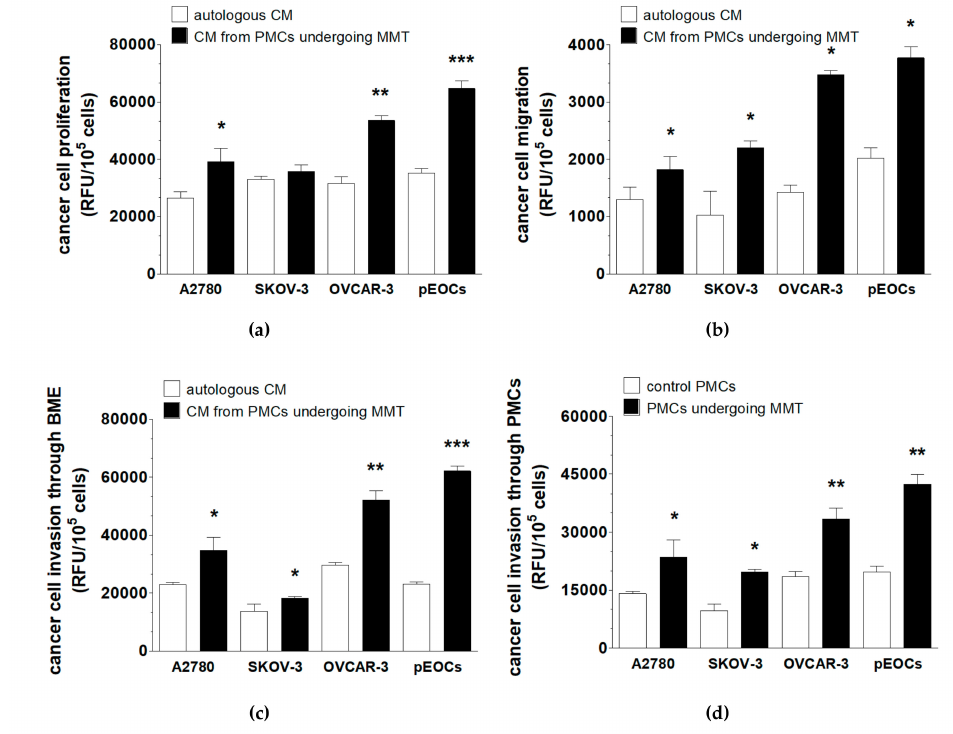
Figure 6. Analysis of the cancer-promoting e ff ects of the PMCs undergoing MMT. E ff ect of the CM generated by cancer cells and PMCs in the MMT state on the proliferation ( a ), migration ( b ), invasion through BME ( c ), and invasion through PMCs ( d ) of the ovarian cancer cells. Experiments were performed with eight separate cultures of PMCs obtained from di ff erent donors, with eight separate cultures of primary epithelial cancer cells (pEOC), and with eight separate cultures of each established cancer cell line. The results are expressed as the mean ± SEM. *, p < 0.05, **, p < 0.01, ***, p < 0.001 vs. autologous CM or the control PMCs. RFU, relative fluorescence units. Table 2. Production of soluble proteins known to contribute to various aspects of ovarian cancer cell progression by the PMCs exposed to autologous and cancer-derived conditioned medium.